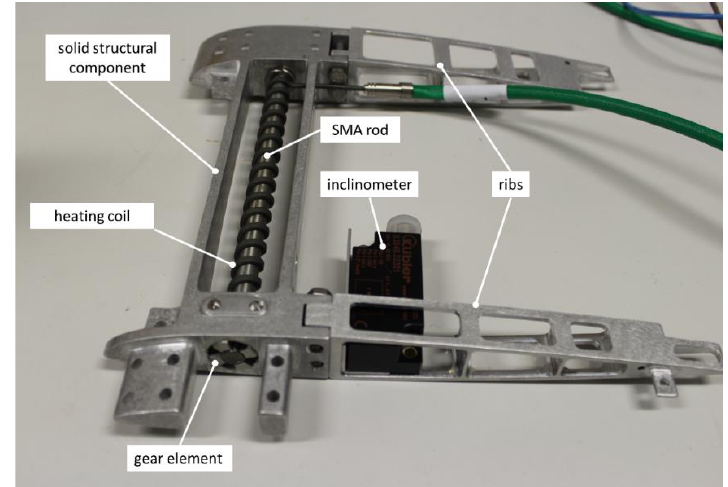
Figure 10. Single frame of the SMA twist architecture.